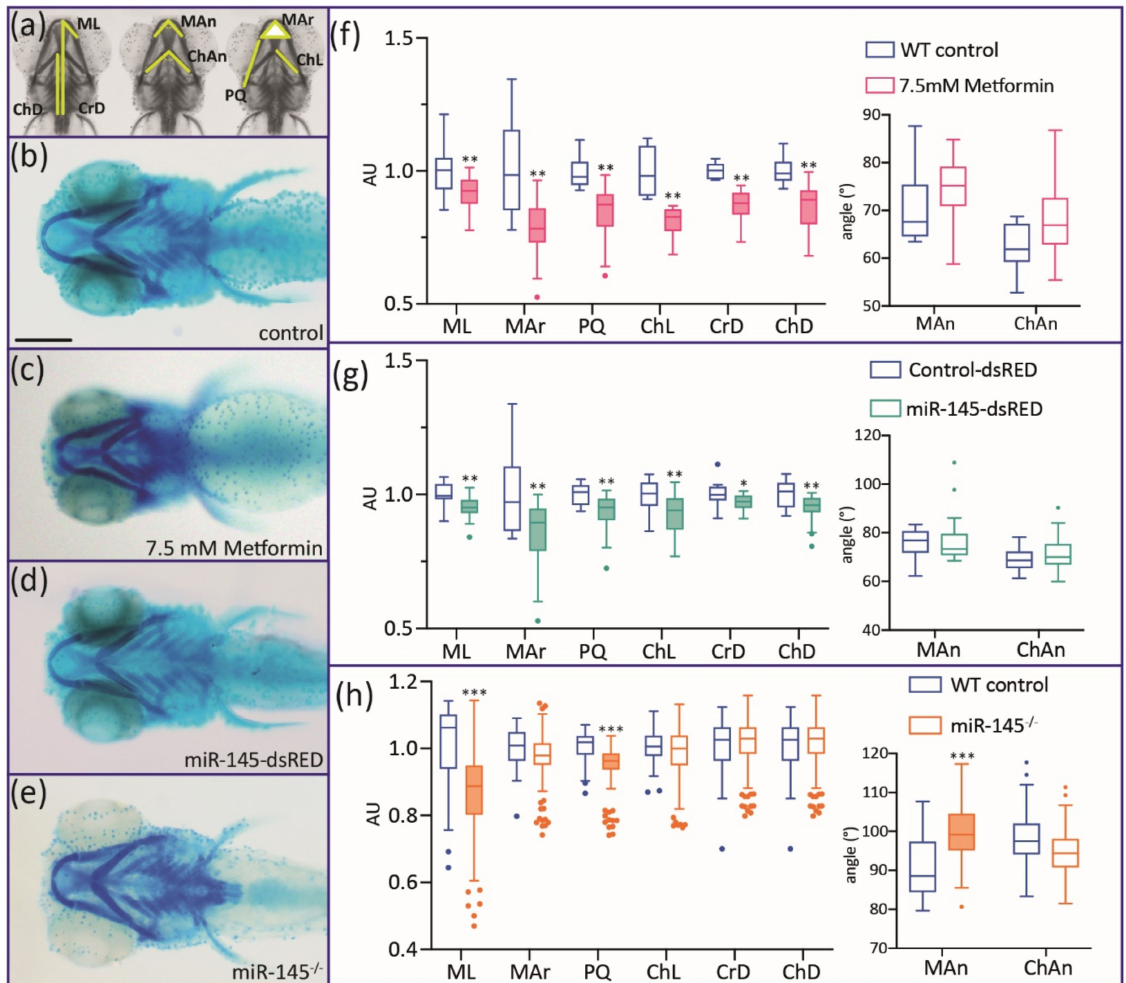
Figure 5. Alcian Blue staining of 5 dpf miR-145-dsRED microinjected, miR-145 − / − mutant, and metformin-treated larvae. ( a ) Different cranial parameters are measured: Mar: Meckel area; ChL: ceratohyal length; PQ: palatoquadrate length; ML: Meckel length; CrD: cranial distance; ChD: ceratohyal-to-fin distance; Man: Meckel angle; ChAn: ceratohyal angle. ( b – e ) Control ( b ), metformin-treated ( c ), miR-145-dsRED microinjected ( d ), and miR-145 − / − mutant ( e ) larvae. All larvae are positioned ventrally with head to the left. ( f – h ) Measurement of cranial parameters corresponding to metformin-treated ( f ), miR-145-dsRED microinjected ( g ), and miR-145 − / − mutant ( h ) larvae compared with their respective controls (WT siblings not treated with drug, Control-dsRED microinjected, and WT siblings, respectively). Arbitrary units (AU) in the y -axis of length and area graphs result from standardization of measurement data to the control counterpart of each parameter. Statistically different parameters have boxplots shaded for easier identification. Two-tailed Student’s t -test, * p < 0.05, ** p < 0.01, *** p < 0.0001. Scale bar represents 200 µ m in ( b ) for ( b – e